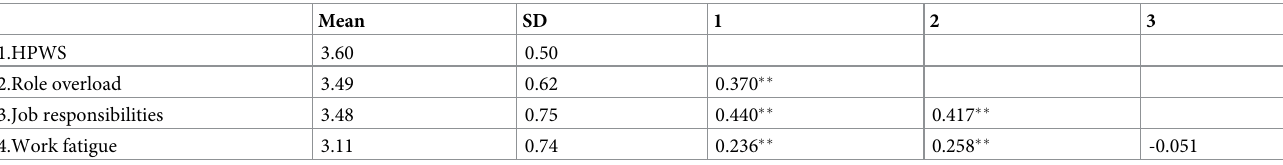
Table 2. Mean value, standard deviation, and correlation